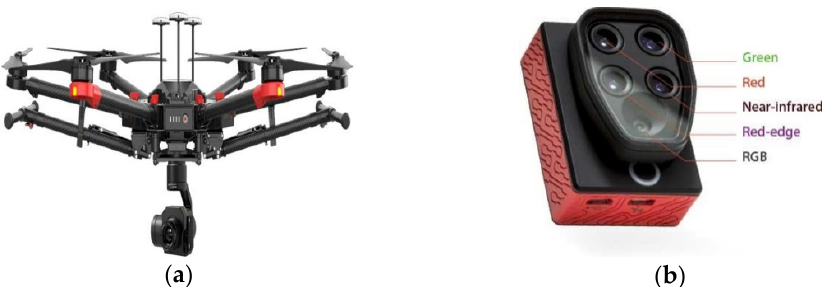
Figure 4. Monitoring equipment fitted with multispectral sensors: ( a ) unmanned aerial vehicle; ( b ) multispectral sensor.